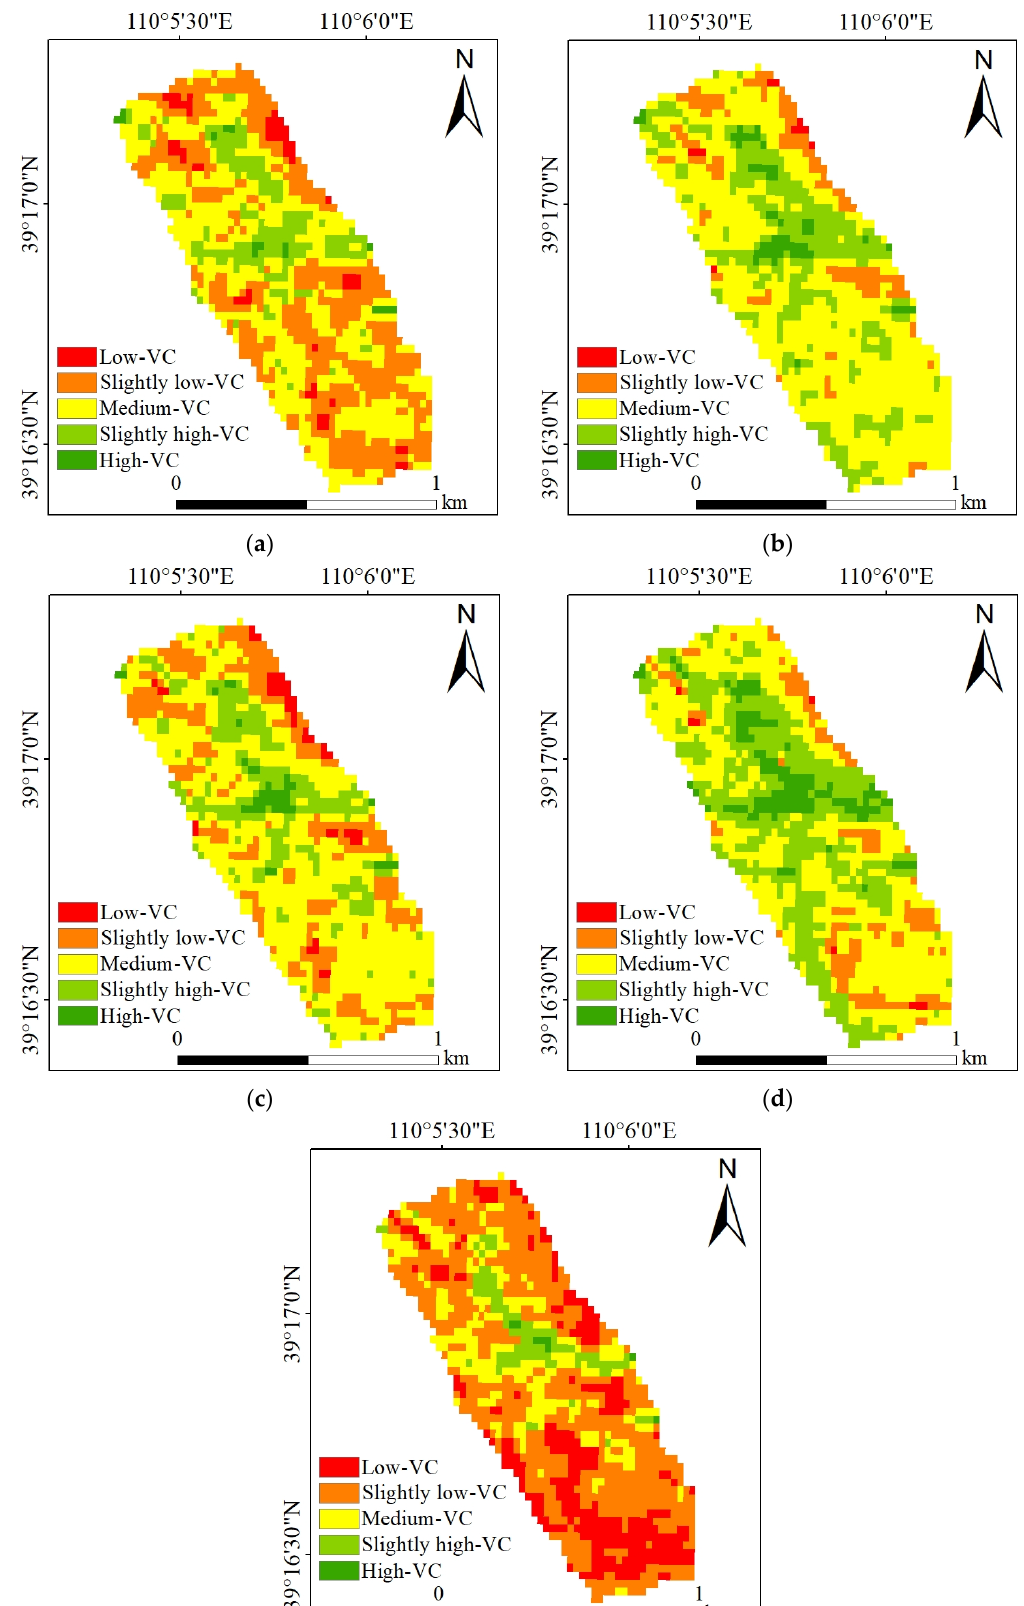
Figure 7. The NDVI grades of the study area: ( a ) 2017; ( b ) 2018; ( c ) 2019; ( d ) 2020; ( e ) 2021.